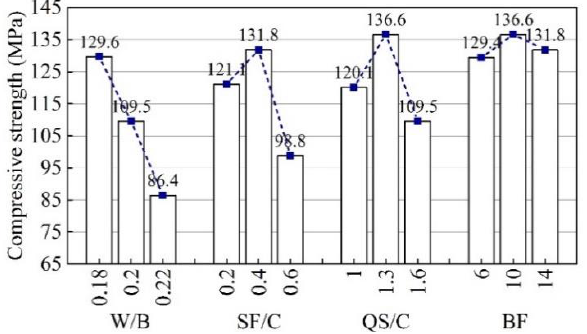
Figure 5. Compressive strength of the BFRPC.